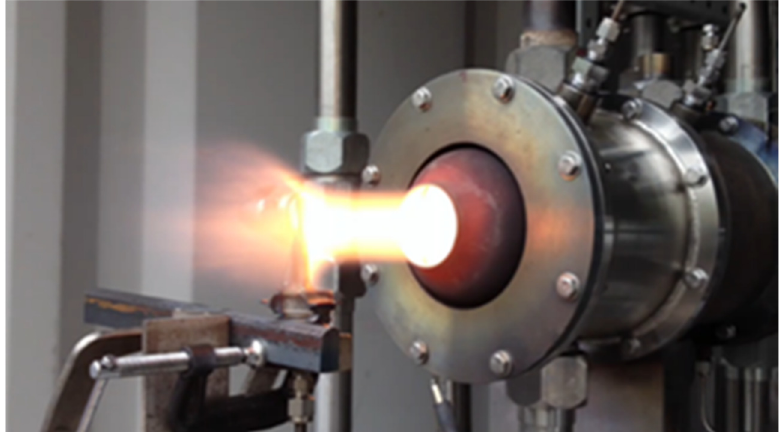
Figure 4. High-temperature jet burner